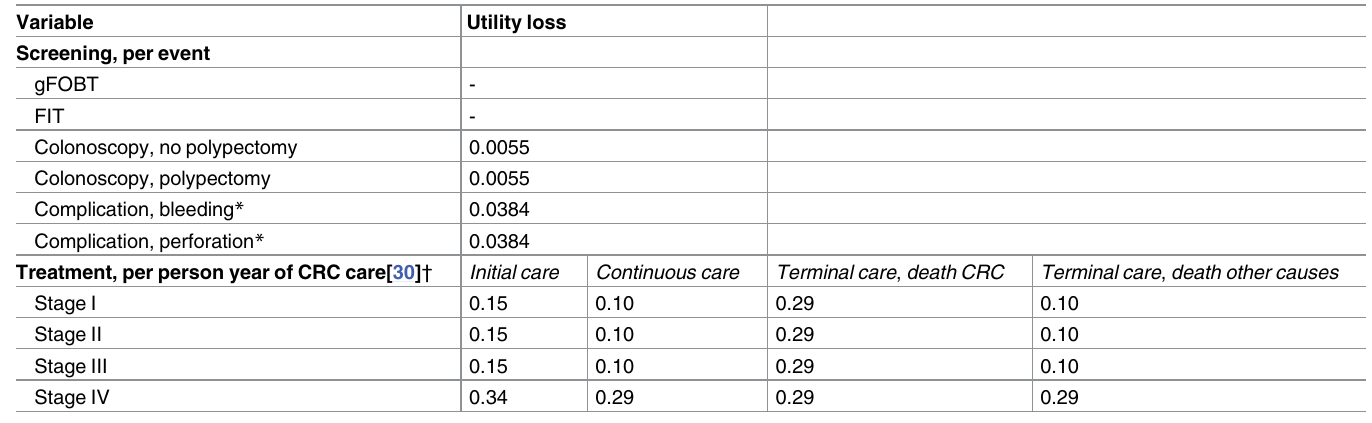
Table 2. Utility weights used in the